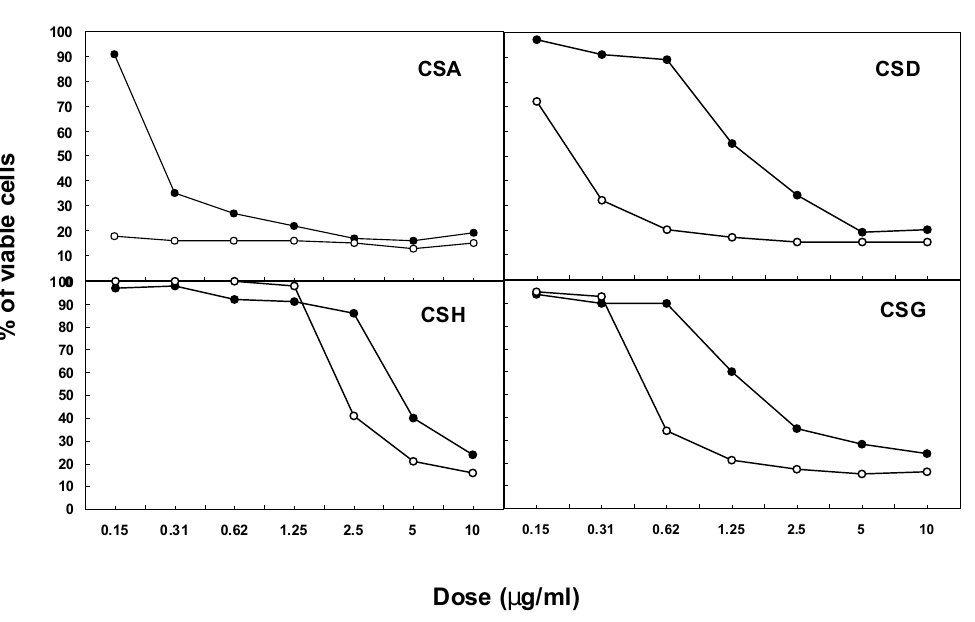
Fig. 4 – Reversal of the resistance to vincristine by cyclosporin analogues. Lucena 1 cells were incubated for 7 days with vincristine (VCR 60 nM) in the presence of cyclosporin A (CSA), cyclosporin D (CSD), cyclosporin H (CSH), cyclosporin G (CSG) and the number of remaining viable cells was counted under phase microscopy. Empty circles represent the effect of CSA or analogues in the resistance of cells toVCR. Black circles represent the cellular toxicity of CSA or analogues